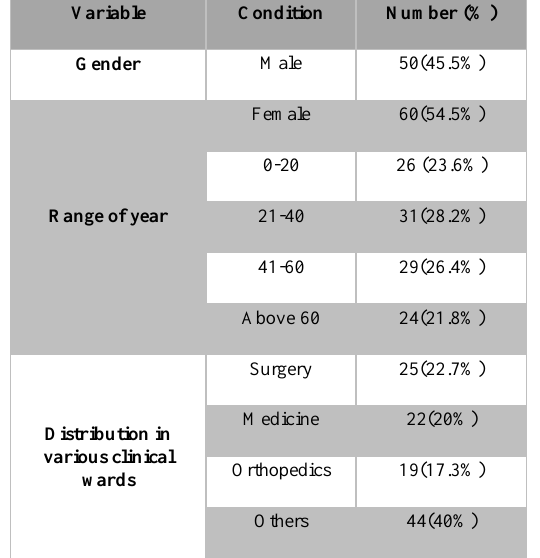
Table 1. Frequency Distribution of some demographic characteristics of patients from whom CoNS species were isolated.